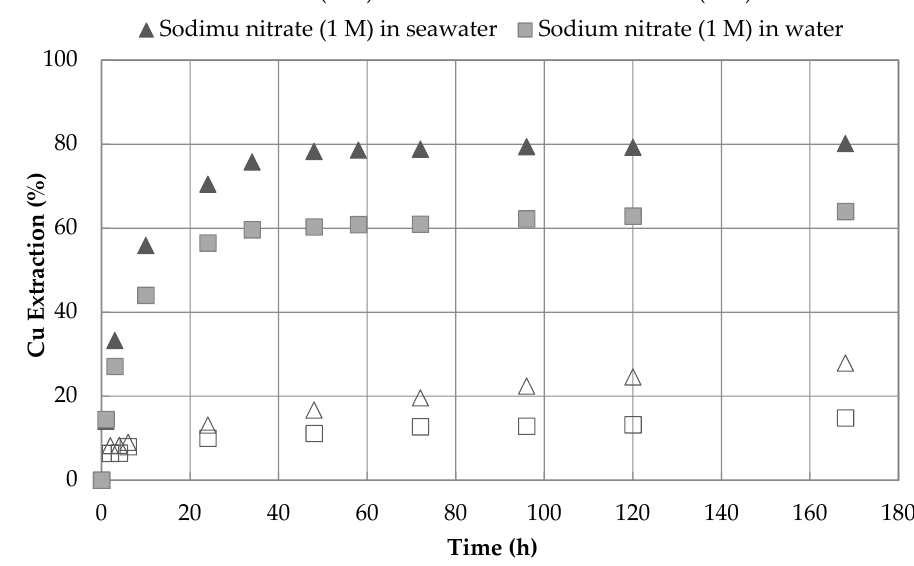
Figure 1. Copper extraction in the leach liquors using H 2 SO 4 (1 M) + NaNO 3 (0 or 1 M) in seawater and water based media (at 45 °C and 7 days).